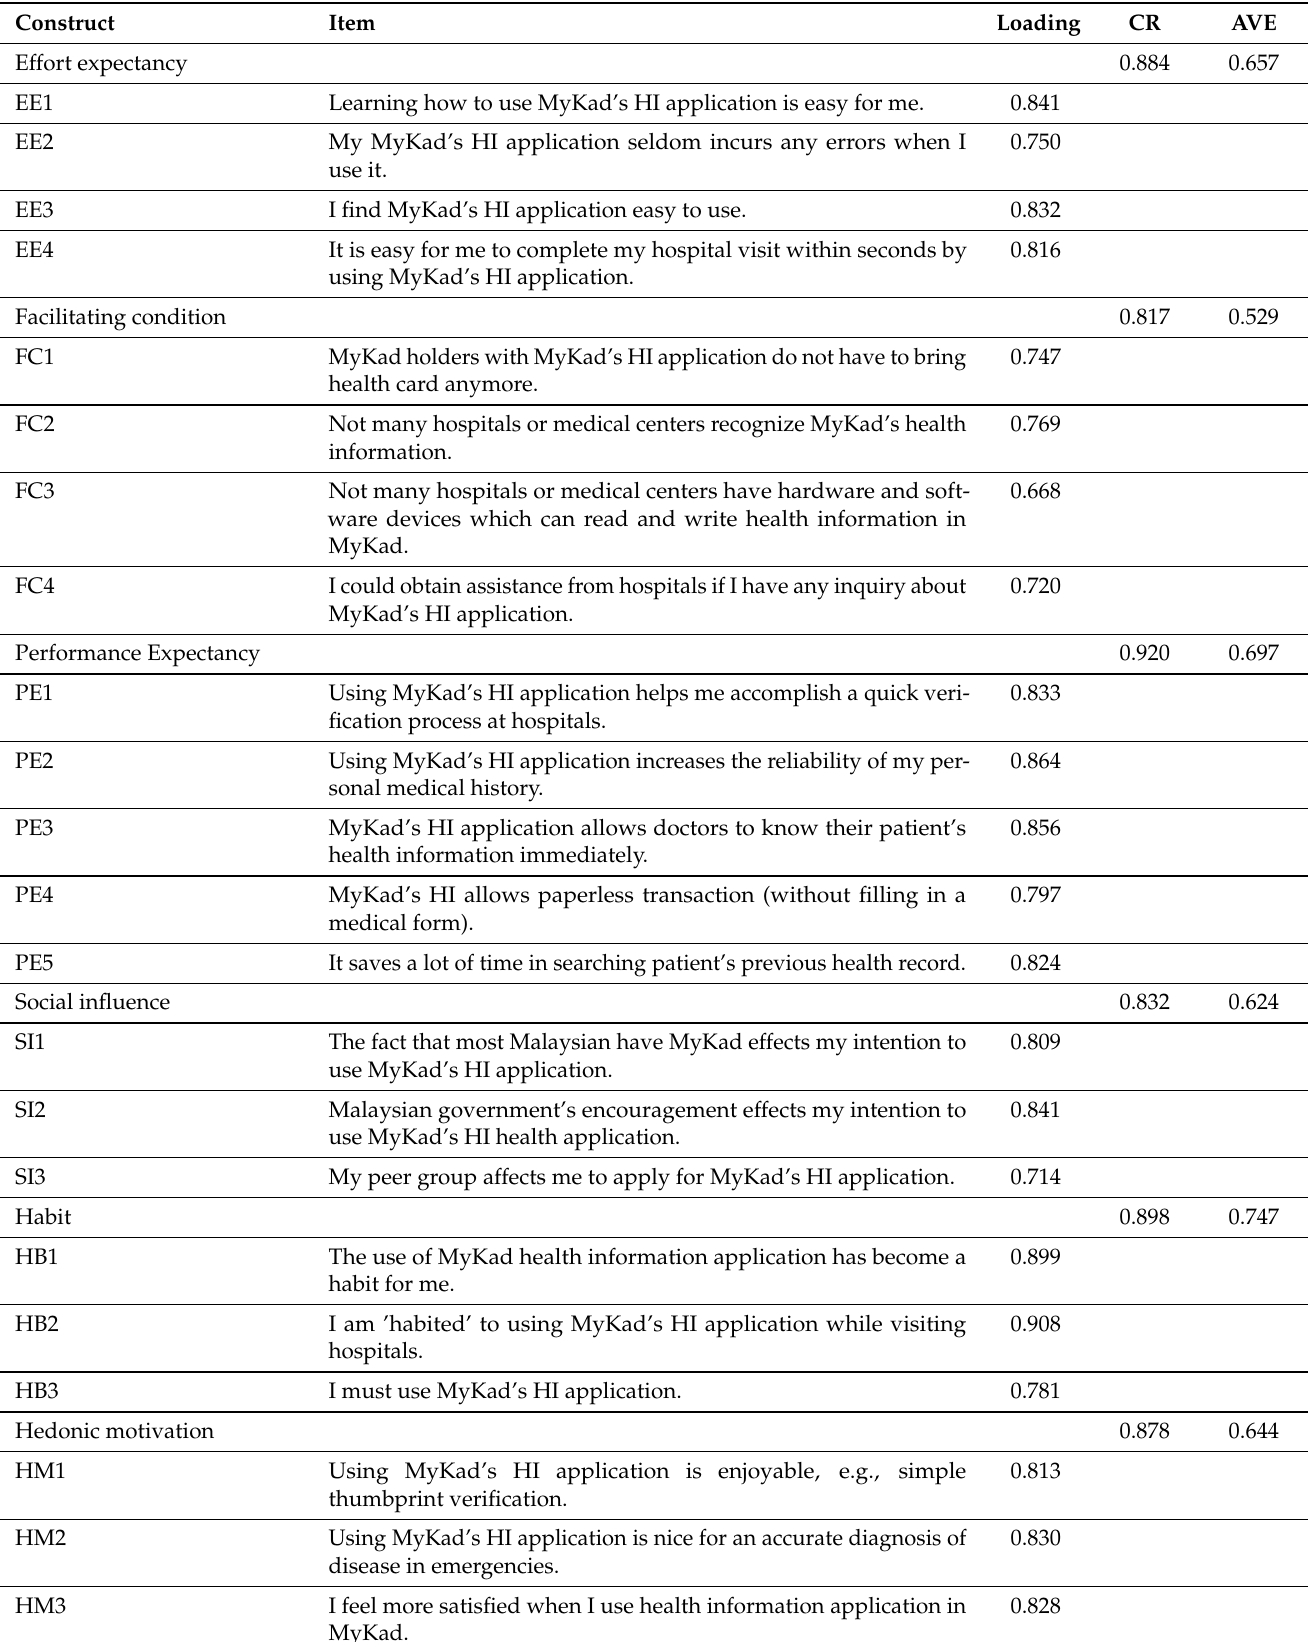
Table 2. Evaluation results of the measurement